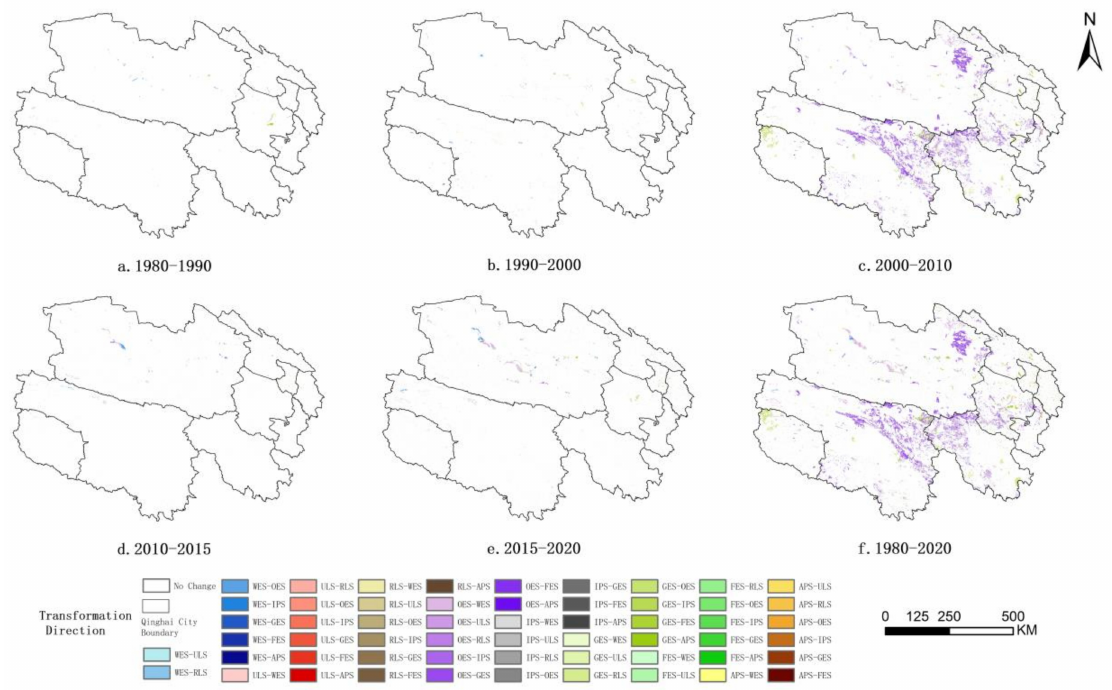
Figure 4. Spatial distribution of territorial space changes in Qinghai Province from 1980 to